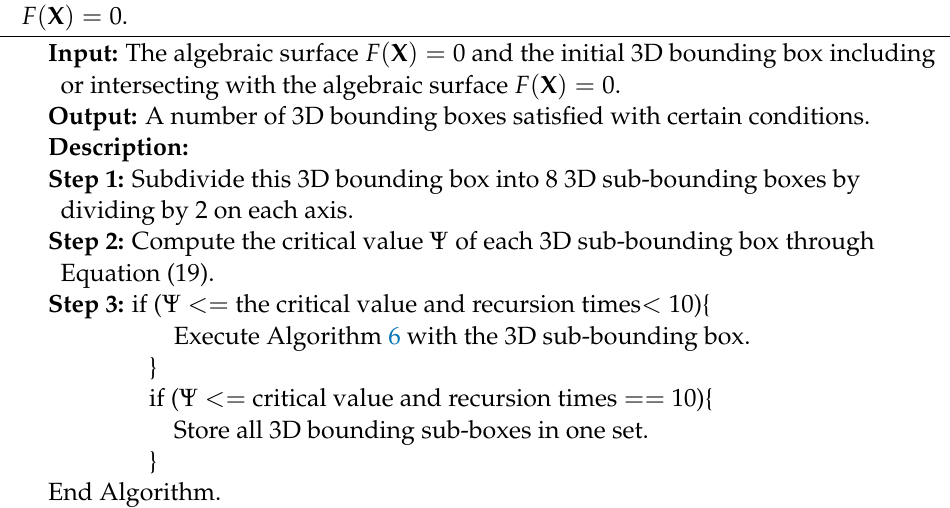
Algorithm 6: To seek out a series of 3D bounding boxes of the algebraic surface F ( X ) =